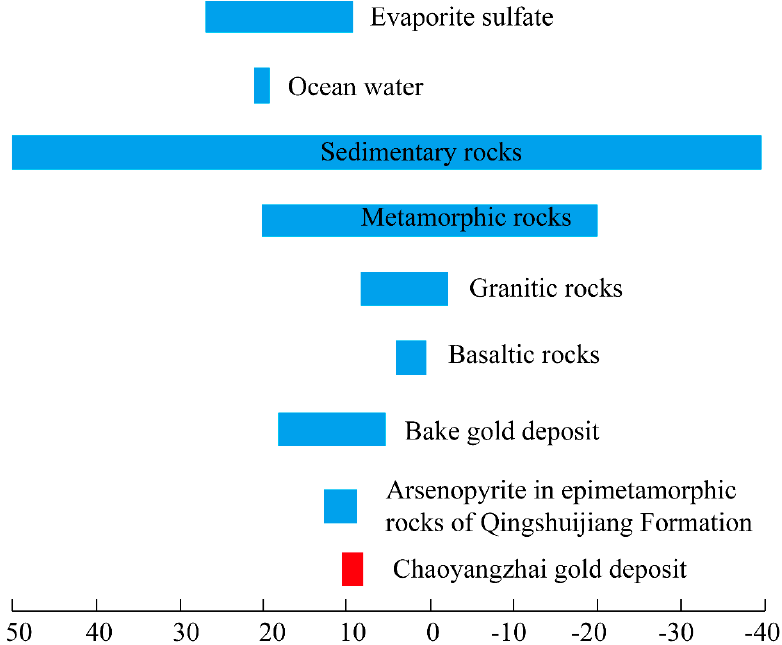
Figure 10. Sulfur isotopic compositions of the Chaoyangzhai gold deposit, showing some important sulfur reservoirs (modified from [59]). The sulfur isotopic data of arsenopyrite in epimetamorphic rocks of Qingshuijiang Formation and Bake deposit are from [8].